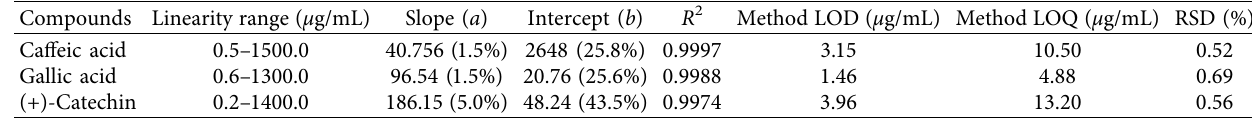
Table 2: Analytical characteristics of the calibration graphs. Compounds Linearity range ( μ